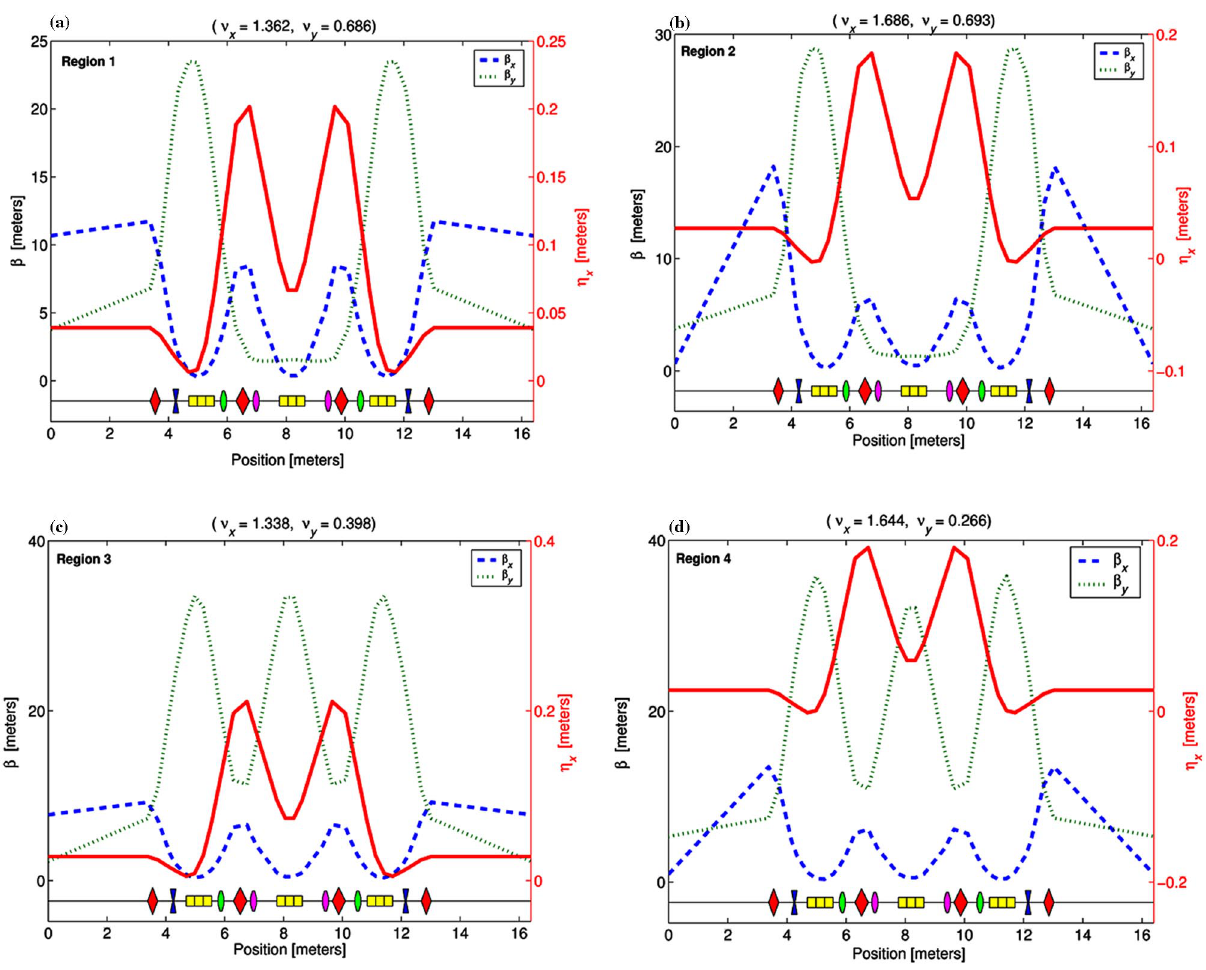
FIG. 8. (Color) A lattice of one of 12 ALS sectors and associated lattice functions in region 1 (top left), region 2 (top right), region 3 (bottom left), and region 4 (bottom right).